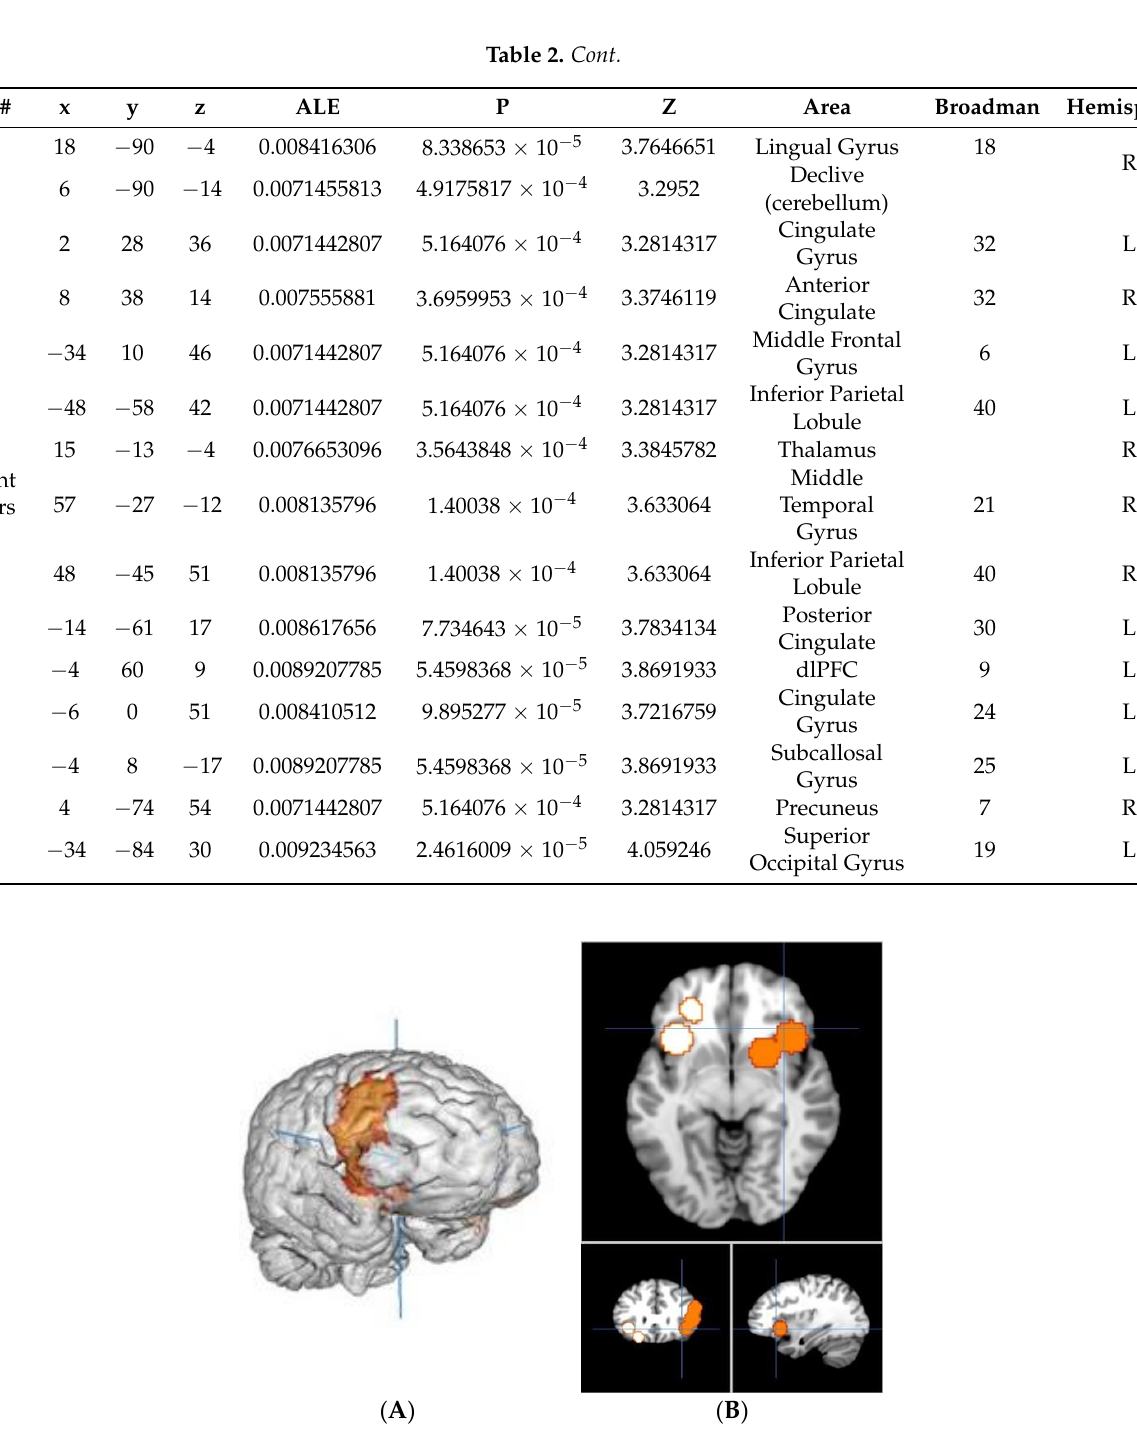
Figure 2. ( A ) Right view of cluster 1; ( B ) slice view of cluster 1 in orange and cluster 2 in